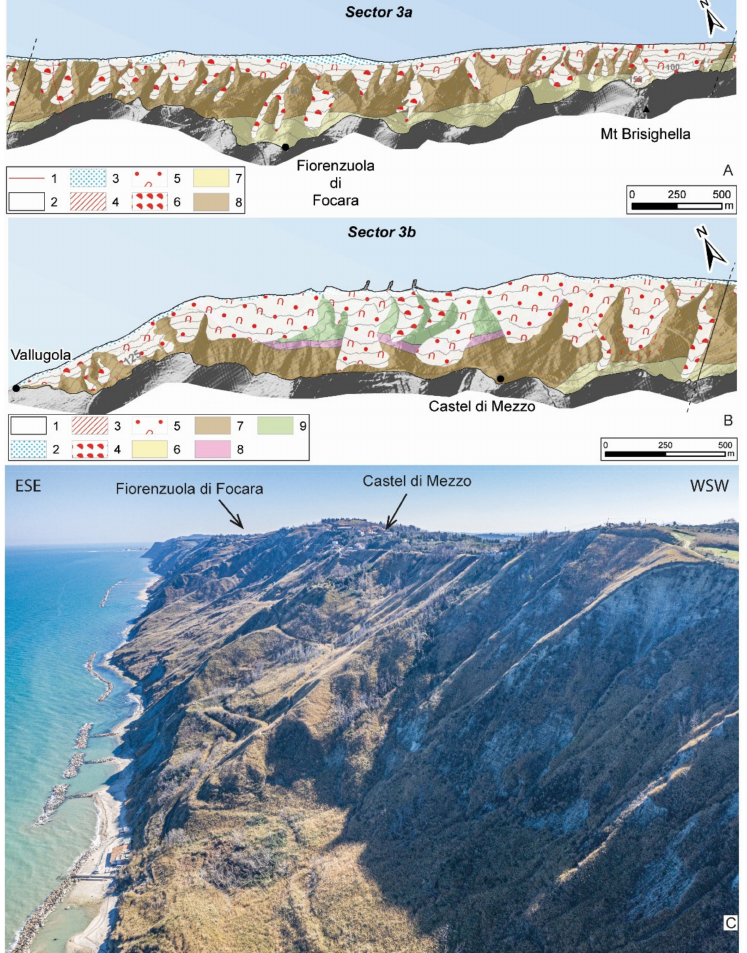
Figure 4. Sector 3 (Mt. Brisighella-Vallugola harbor) of the Mt. San Bartolo coastal slope. ( A ) Detailed geomorphological map of sector 3b: 1, Sector border; 2, Beach; 3, Landslide scarp; 4, Flow; 5, Slump; 6, Colombacci Formation; 7, San Donato Formation; 8, Gessoso Solfifera Formation; 9, Schlier Formation. ( B ) Detailed geomorphological map of sector 3a: 1, Strike-slip fault; 2, Sector border; 3, Beach; 4, Landslide scarp; 5, Slump; 6, Flow; 7, Colombacci Formation; 8, San Donato Formation. ( C ) Panoramic view toward the